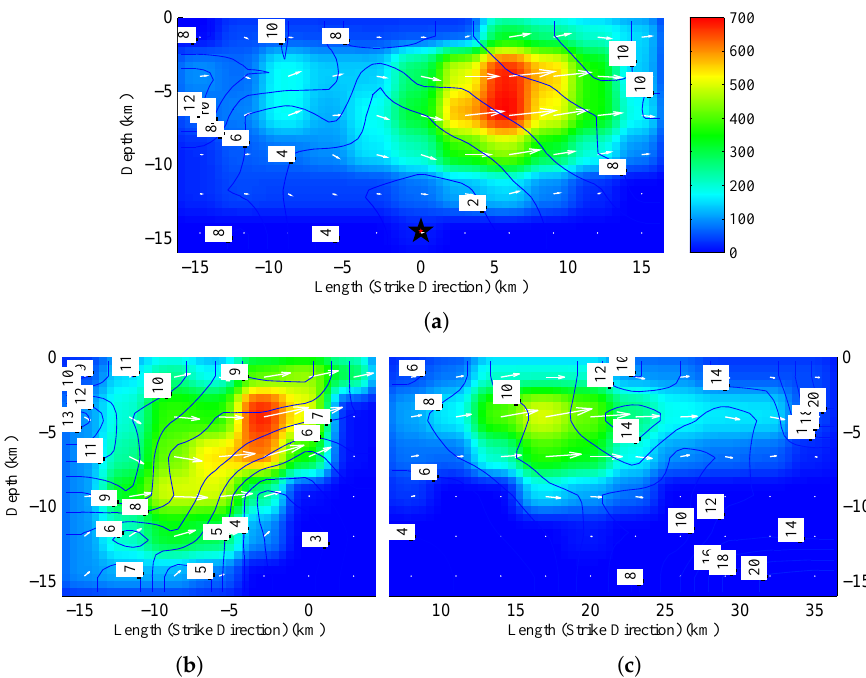
Figure 4. Fault segments of [49,50] source model for the 1999 M w 7.1 Hector Mine earthquake, resampled to a subfault dimension of 0.5 km. Color map: Slip distributions in centimeters. Arrows: Slip direction. Counters: Rupture times in seconds. Star: Hypocenter of the event. ( a ) Fault Segment 1, ( b ) Fault Segment 2, and ( c ) Fault Segment 3.